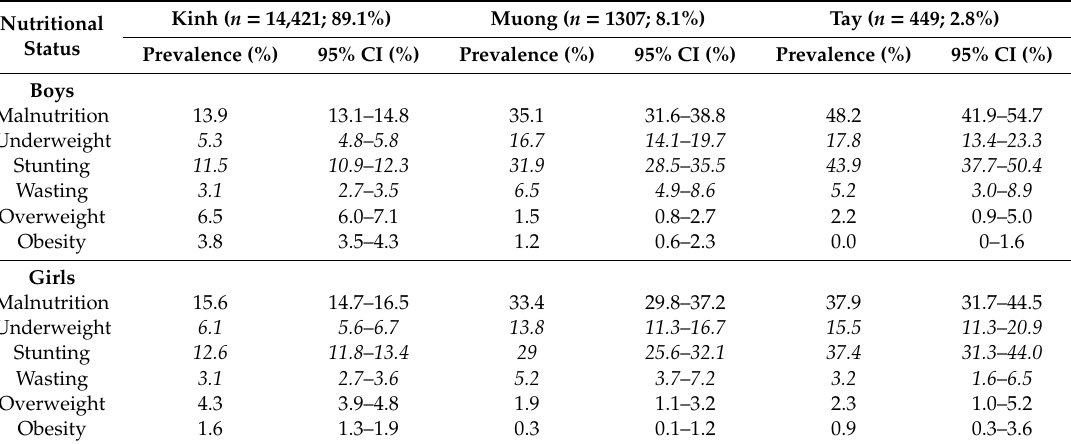
Table 1. Prevalence of various nutritional statuses across ethnic groups among 24–60 month old children in Northern